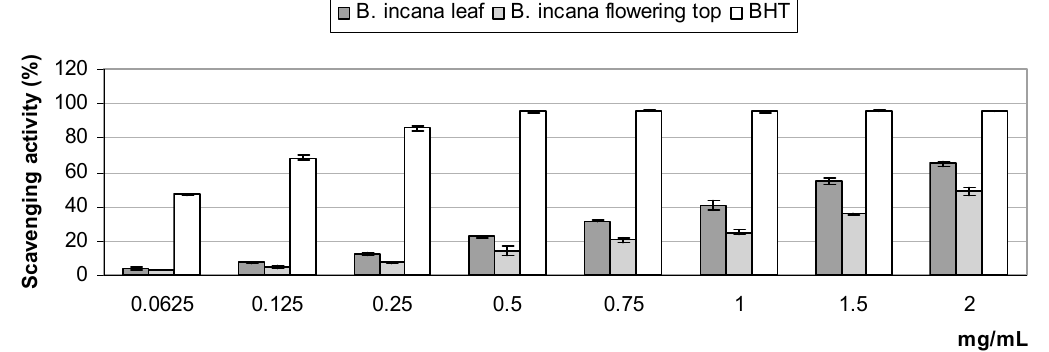
Figure 2. Free radical scavenging activity (2,2-diphenyl-1-picrylhydrazyl (DPPH) test) of B. incana leaf and flowering top hydroalcoholic extracts. Values are expressed as the mean ± SD ( n = 3).